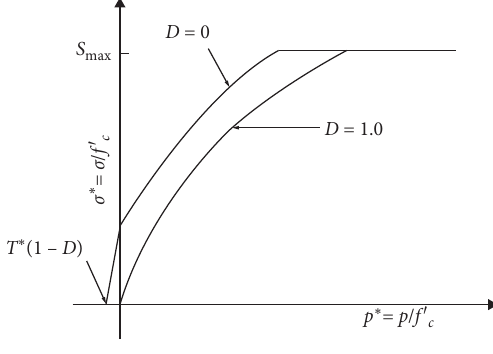
Figure 4: Constitutive law of JHC model.